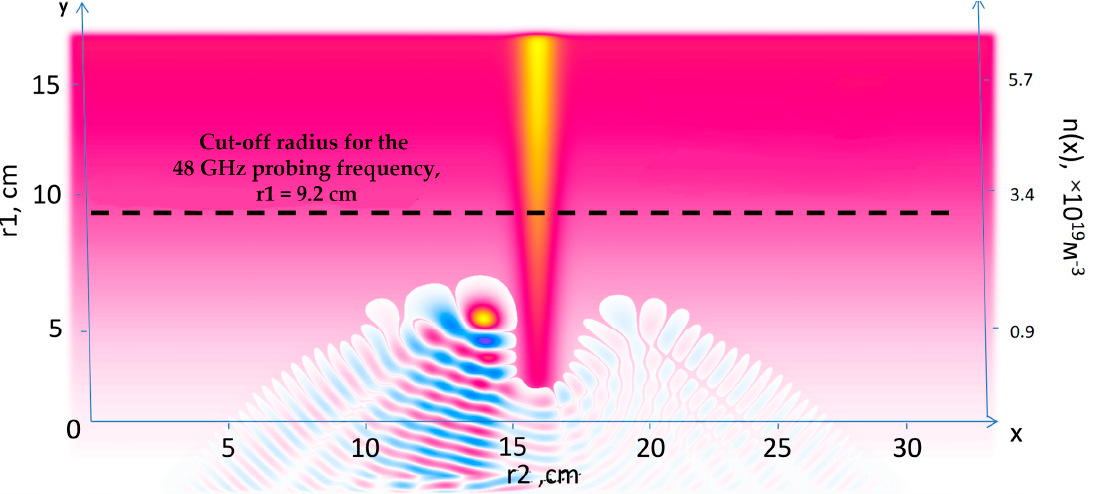
Figure 20. Density perturbations with an introduced strip filament (yellow vertical line). The electric field distribution is also presented.